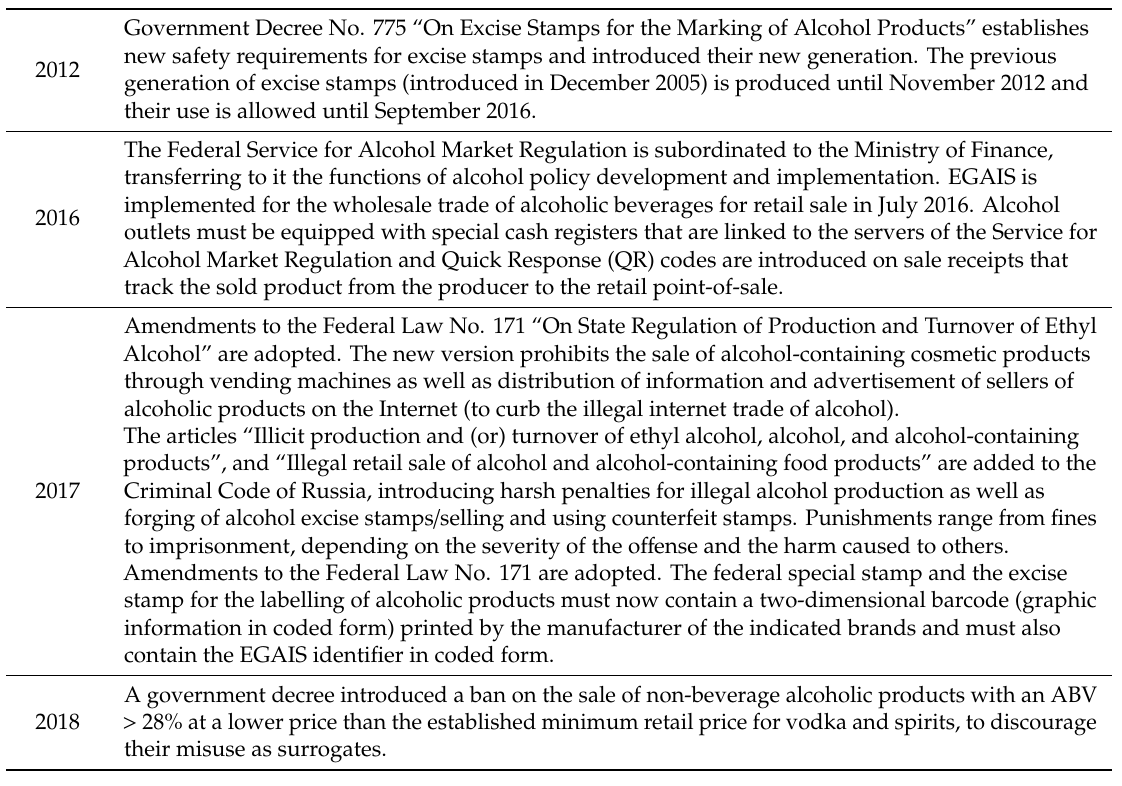
Table A6. Overview of most important law changes addressing unrecorded alcohol since 2009. Source: Consultant.ru.